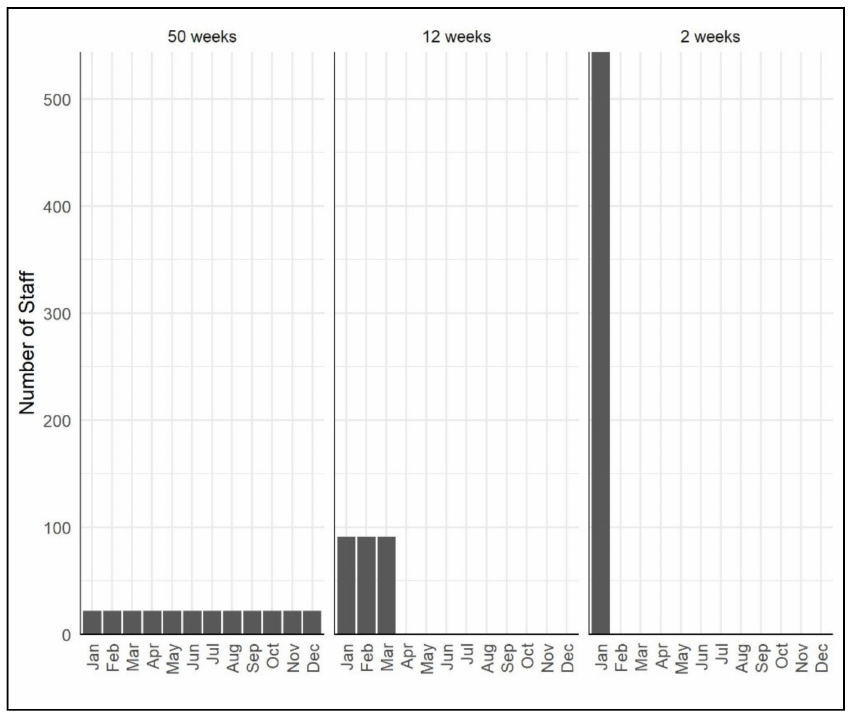
Figure 2. Sta ff requirement for campaigns vaccinating 70,000 dogs using CVR (11 dogs / person / day) and DD (41.5 dogs / person / day) methods over a period of 50 weeks, 12 weeks and 2 weeks requiring 22, 91 and 544 people respectively. Estimates of sta ff were generated using the VaxPLAN calculator (Supplementary Materials)